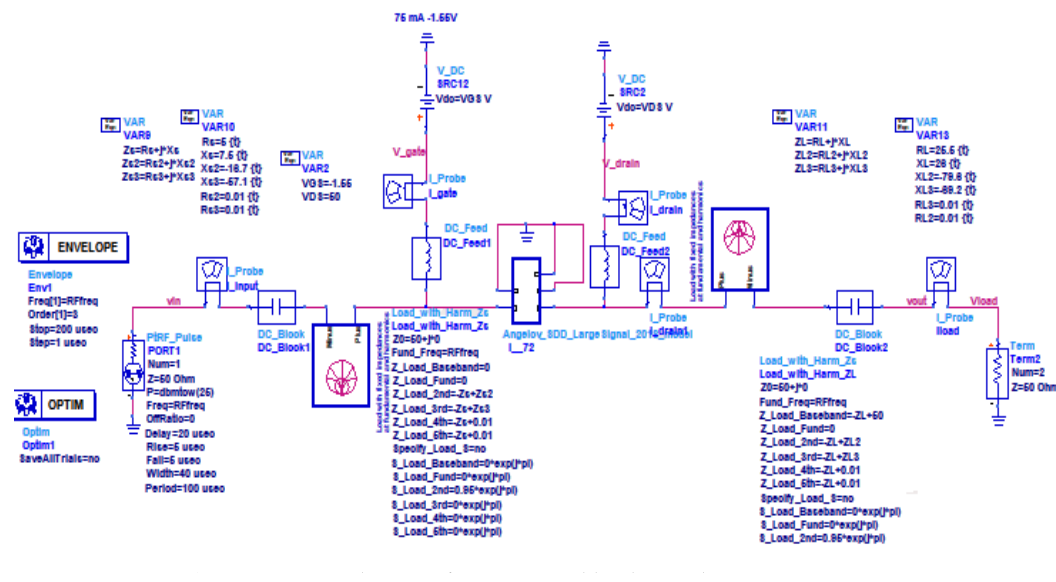
Figure 11. ADS schematic for source and load impedance optimization.